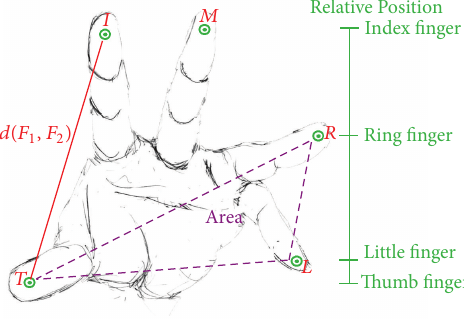
Figure 2: Example of hand’s physiological biometric.